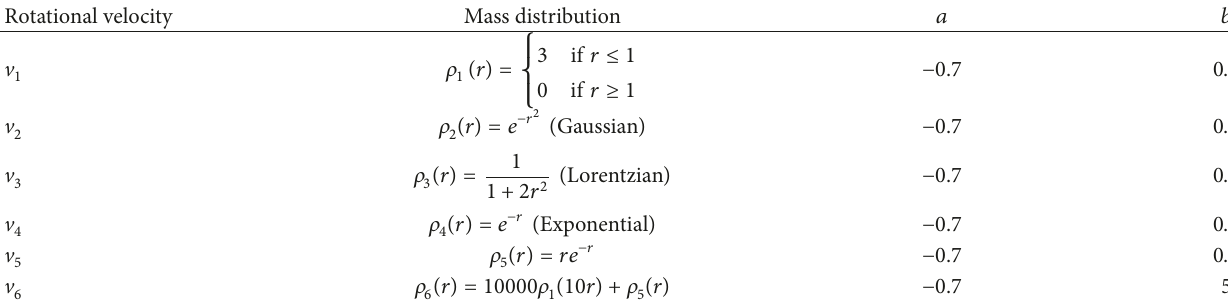
Rotational velocity Mass